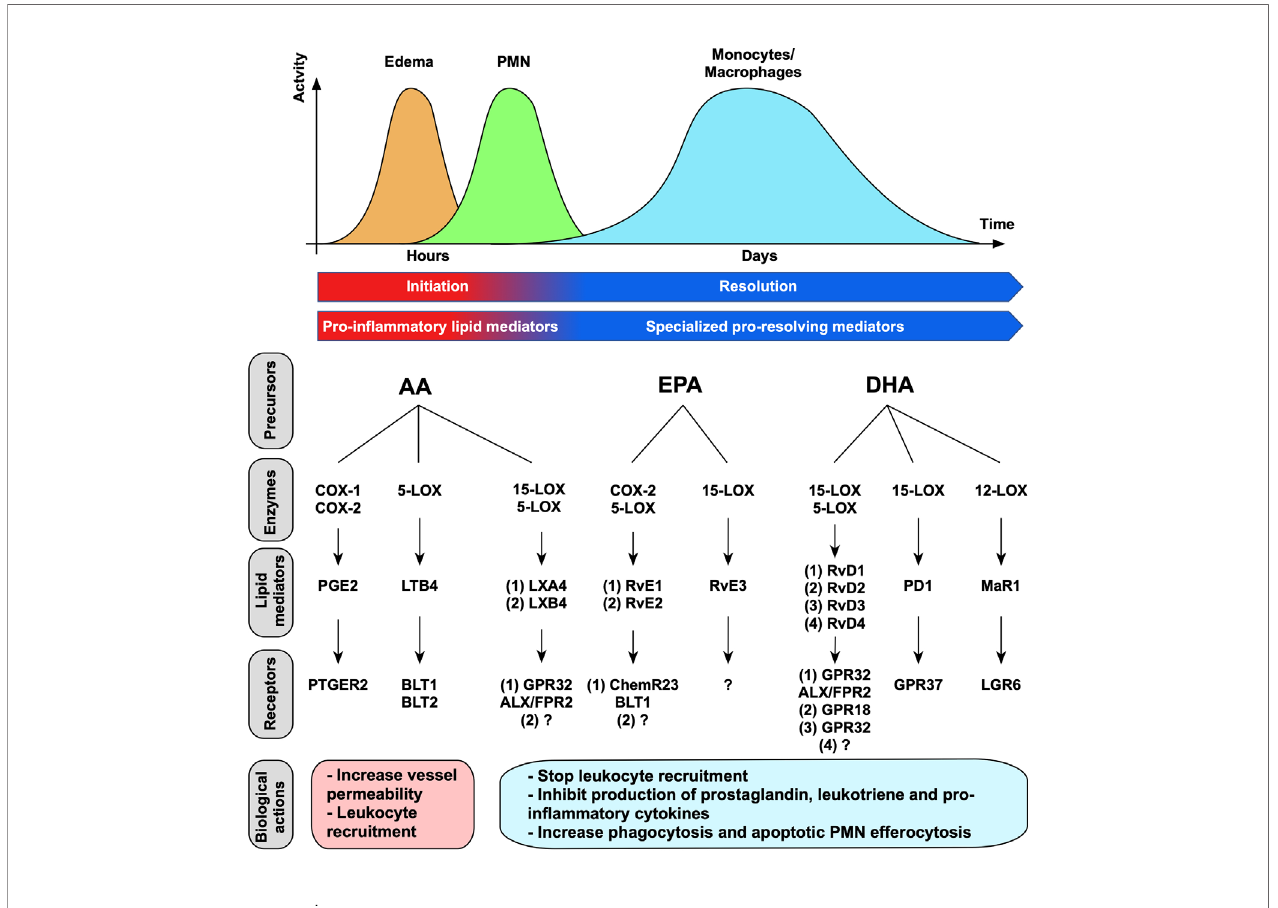
FIGURE 1 | Lipid mediators ’ time-course, synthesis and biological actions. Lipid mediators are produced sequentially through action of speci fi c enzymes. Pro- in fl ammatory lipid mediators (prostaglandins and leukotrienes) are fi rst produced during in fl ammation initiation. During in fl ammation resolution, a switch in lipid mediator synthesis occurred and promote SPMs ’ synthesis. Each SPM execute its functions by binding to a speci fi c receptor. The receptors for LXB4, RvE2, RvE3, RvD4 have not been characterized yet (14 –